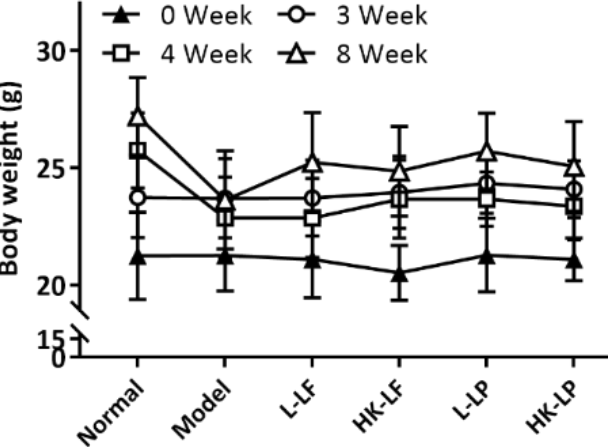
Figure 4. Change sin body weight. L-LF: live LF group; HK-LF: heat-killed LF group; L-LP: live LP group; HK-LP: heat-killed LP group.